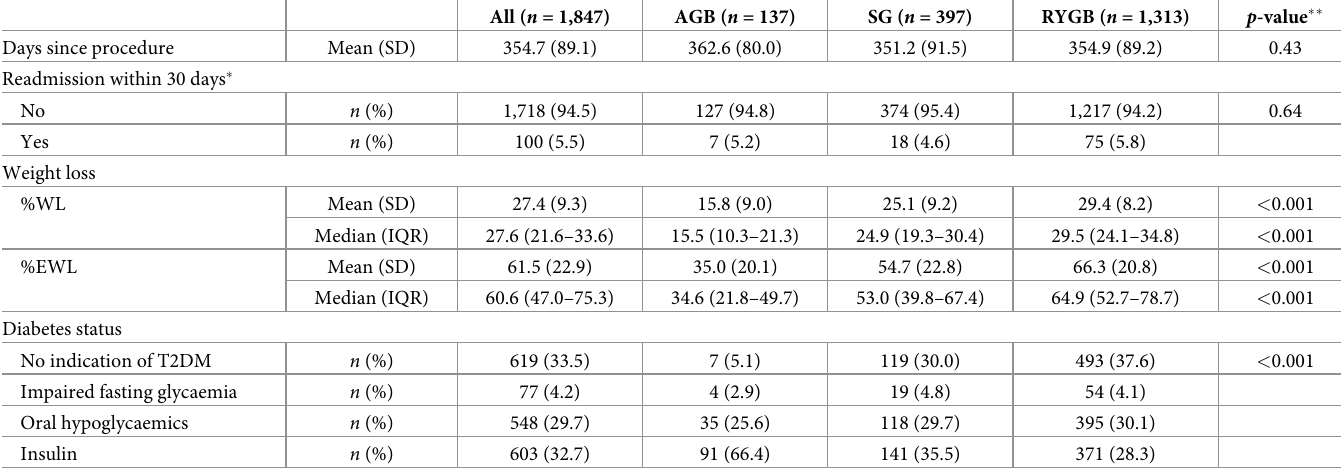
Table 2. Outcomes for surgical patients at 1-year follow-up by procedure ( n = 1,847).